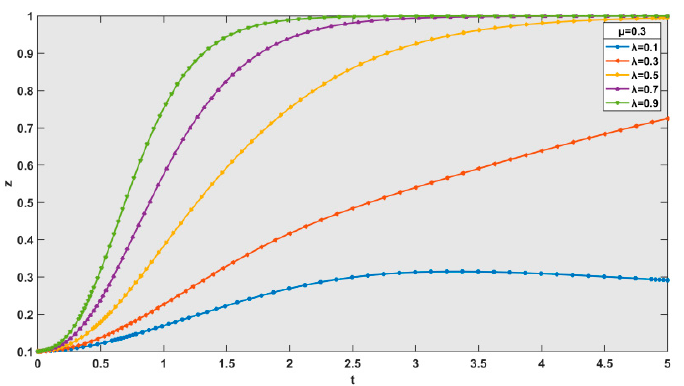
Figure 13. The combination strategy of λ and µ on the potential demand-oriented enterprises’